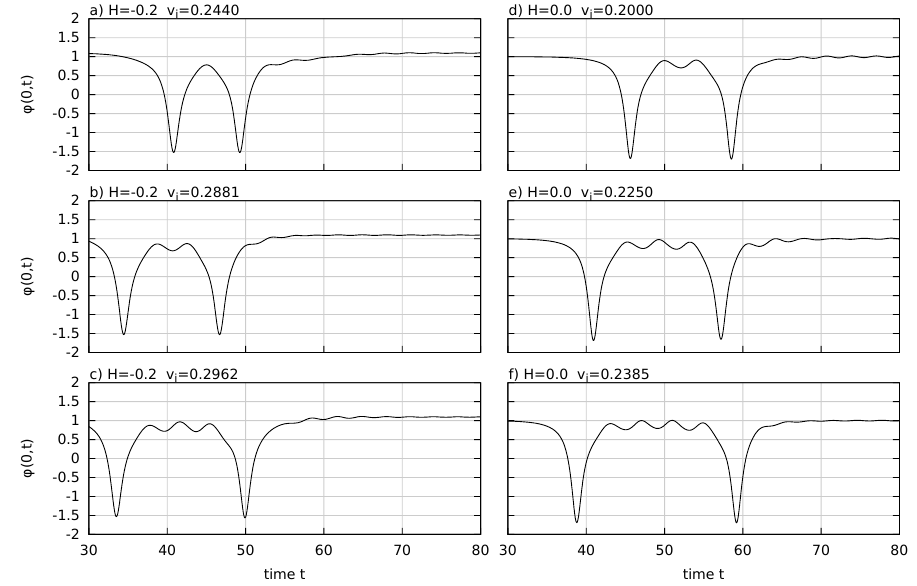
Figure 9 . Plots of (cid:30) (0 ; t ) for v i inside the (cid:12)rst three two-bounce windows for H = (cid:0) 0 : 2 (left) and for H = 0